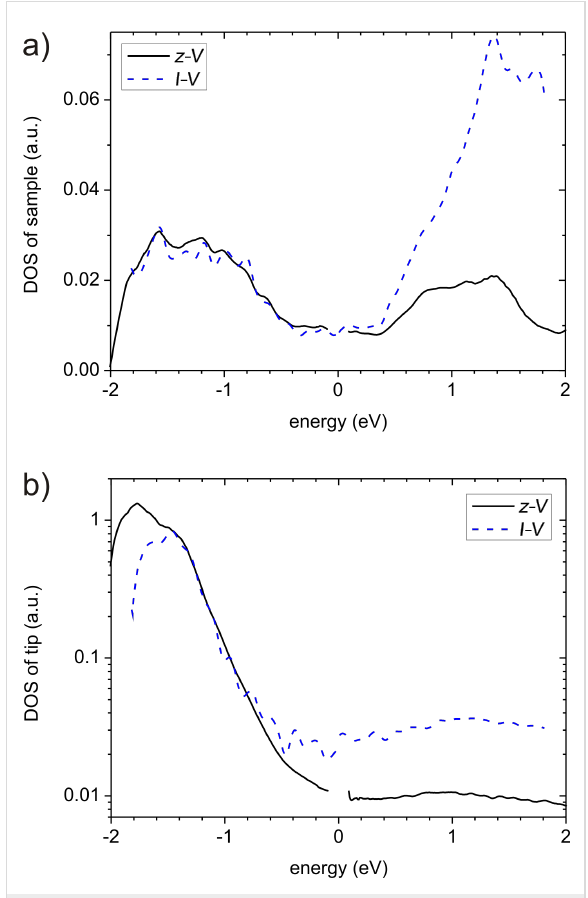
Figure 4: Recovered and deconvolved DOS’s of the sample derived from z – V measurements (black solid) and I – V measurements (dashed). Parameters used in the calculations are: z 0 = 0.4 nm for z – V and z 0 = 0.6 nm for I – V spectroscopy, β = 2, γ = 1.11 for positive and γ = 1.0 for negative